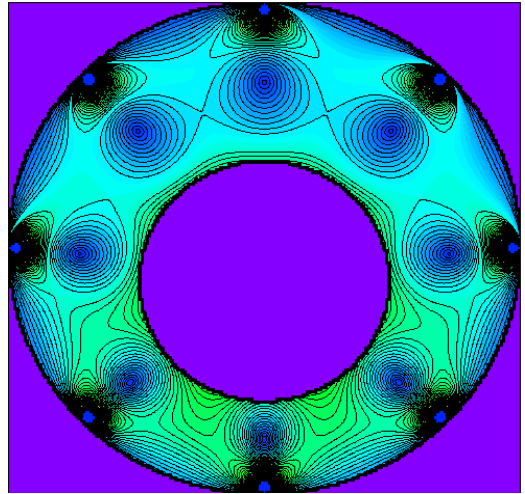
Figure 23. Isochromatic fields for the eccentric ring symmetrically loaded by eight concentrated equidistant forces: 𝜆 ∥ = 1; 𝜆 (cid:2884) = 1; 𝜆 = 1; 𝜃 (cid:2869) = 𝜋 4⁄ ; 𝜃 (cid:2870) = −𝜋 4⁄ .